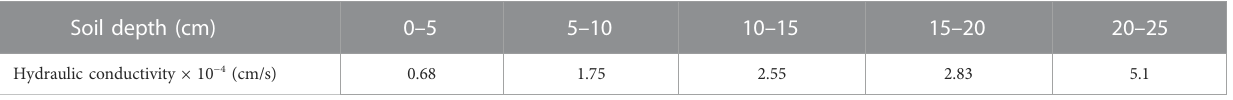
TABLE 2 Hydraulic conductivity of alpine meadow